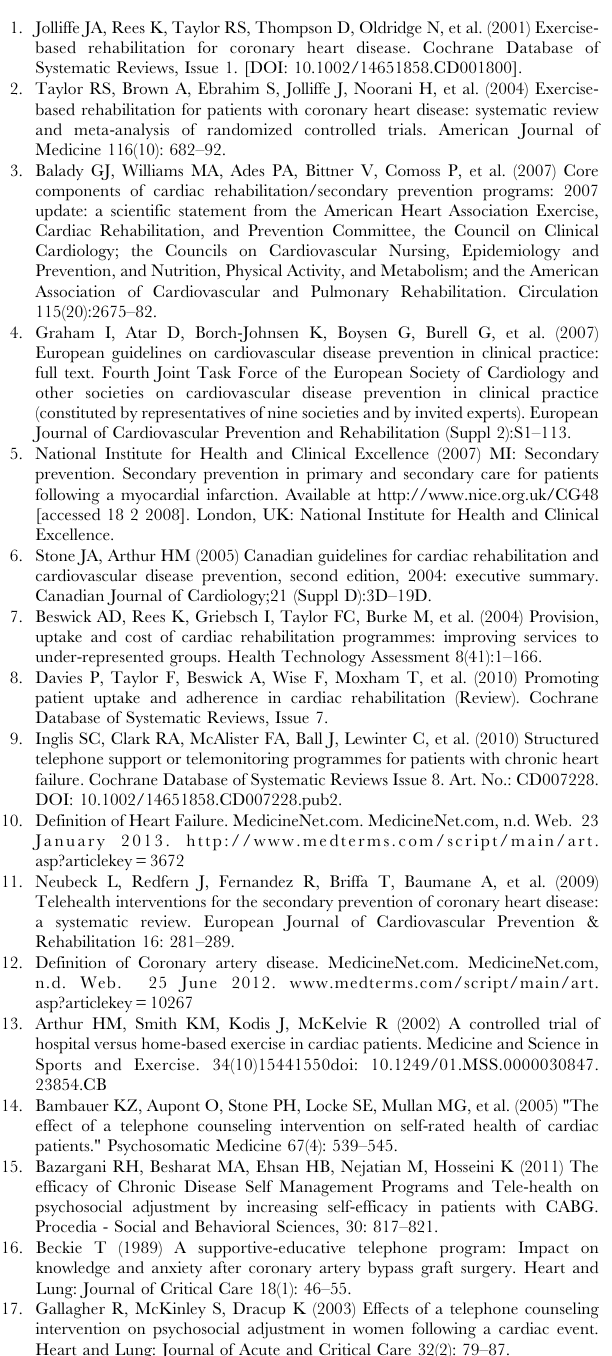
Figure S7 Sensitivity analysis comparing structured telephone support and usual care on anxiety in studies of at least 3 months of follow-up. Figure S8 Sensitivity analysis comparing structured telephone support and usual care on anxiety in studies of at least 6 months of